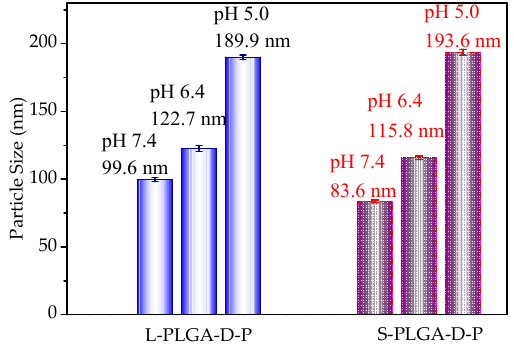
Figure 4. The size variations of polymeric micelles with pH values.